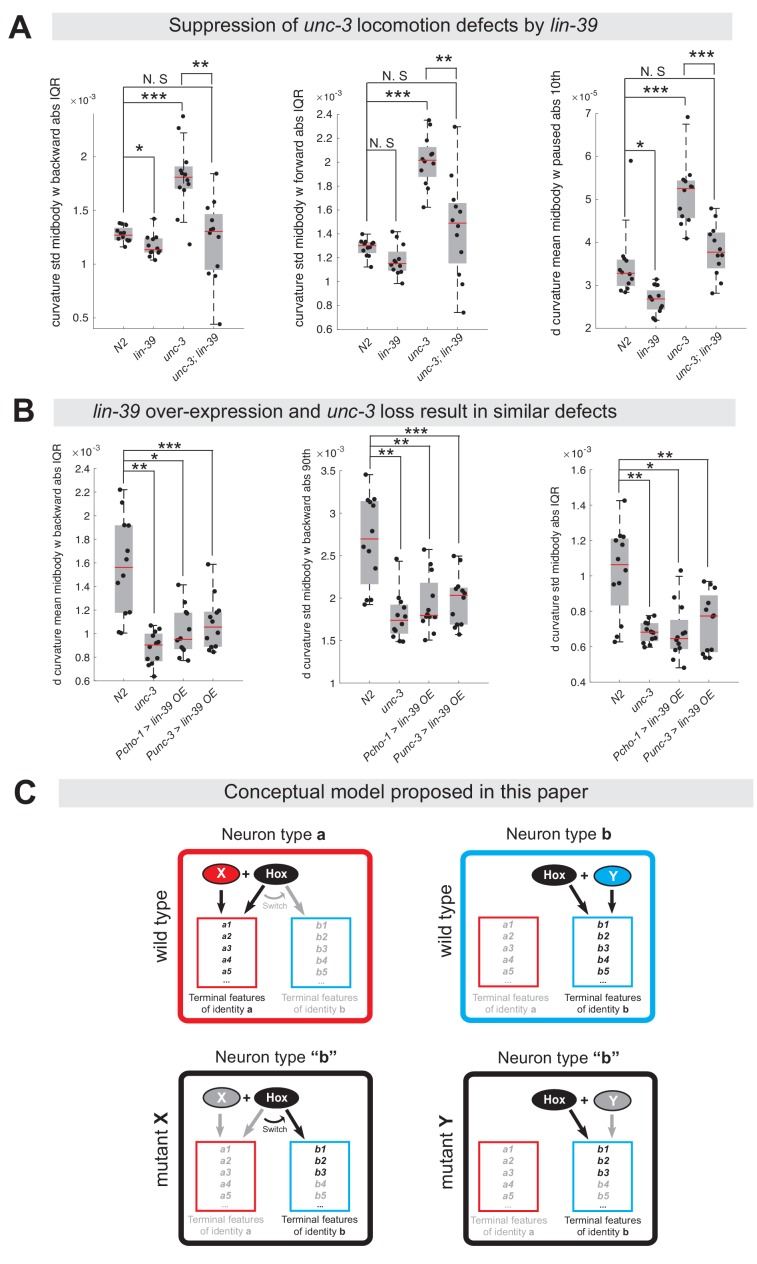
Ectopic expression of VD terminal identity genes in cholinergic motor neurons is associated with locomotion defects.(A) Examples of three mid-body locomotion features that are significantly affected in unc-3 (n3435) animals, but markedly improved in unc-3 (n3435); lin-39 (n1760) double mutant animals. Each black dot represents a single adult animal. The unit for the first two graphs is 1/microns. The unit for the graph on the right is 1/(microns*seconds). N = 12. Additional mid-body features affected in unc-3 (n3435) animals, but improved in unc-3 (n3435); lin-39 (n1760) mutants are provided in Figure 10—figure supplement 1 and Supplementary file 3. *p<0.01, **p<0.001, ***p<0.0001. (B) Examples of three mid-body locomotion features affected in unc-3 (n3435) mutants and animals over-expressing lin-39 in cholinergic MNs. Each black dot represents a single adult animal. The unit for the Y axis is 1/(microns*seconds). N = 12. Additional mid-body features affected in unc-3 (n3435) and lin-39 over-expressing animals are provided in Figure 10—figure supplement 1 and Supplementary file 3. *p<0.01, **p<0.001, ***p<0.0001. (C) Conceptual model summarizing the findings of this paper. Gray font: not expressed gene. Black font: expressed gene. Gray arrow: inactive genetic interaction. Black arrow: active genetic interaction.